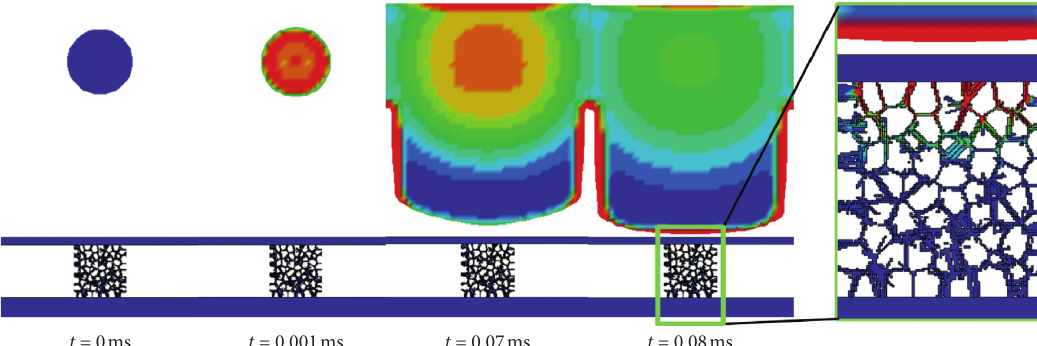
Figure 12: Explosion shock wave reaches the cover plate and begins to compress the aluminum foam.